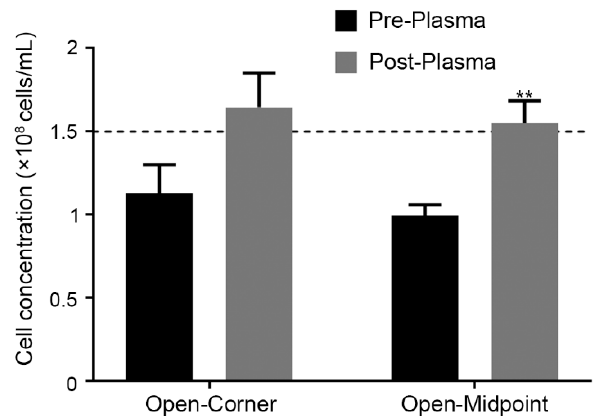
Figure 5. Comparison of the SSCC device with and without plasma bonding to a glass microscope slide for counting of zebrafish sperm (1.5 × 10 8 cells/mL) ( n = 5; mean ± SEM) with a t -test ** indicates P = 0.006. The dashed line indicates the solution concentration.